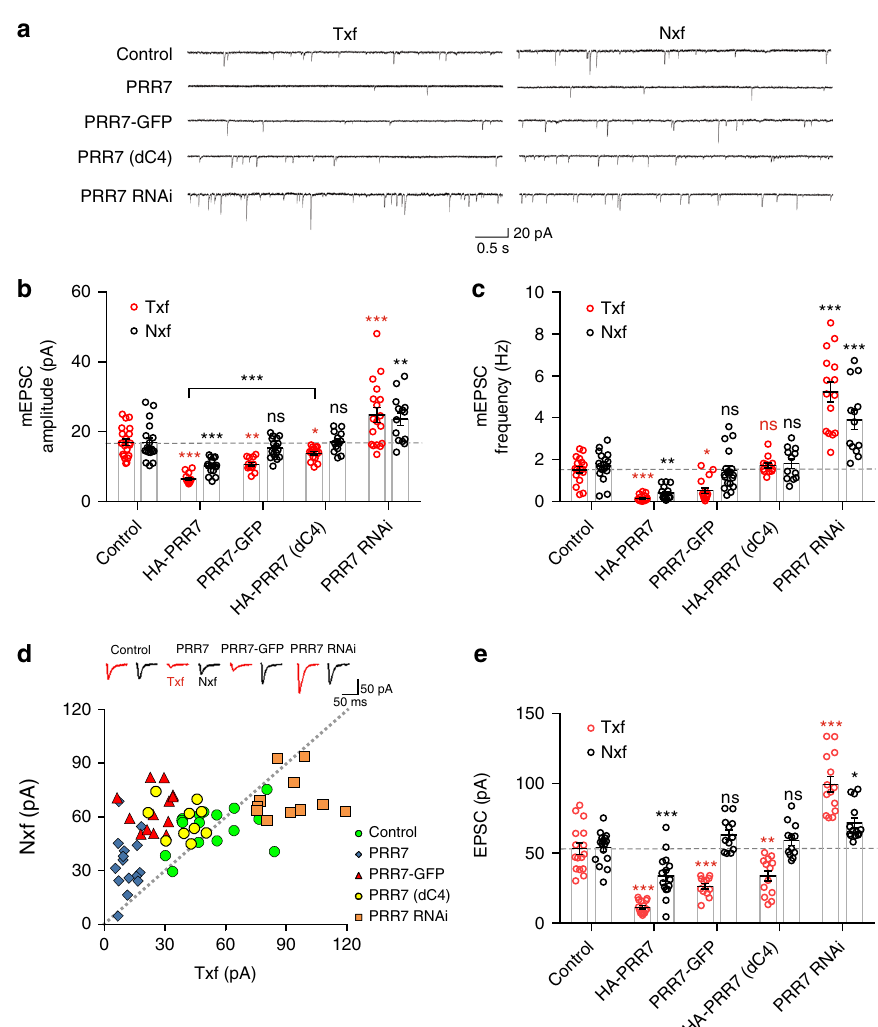
Fig. 3 PRR7 regulates excitatory synaptic transmission of local hippocampal neurons. a – c Effect of various PRR7 constructs on AMPAR-mediated mEPSCs in dissociated hippocampal neuron culture. Representative traces ( a ) and quanti fi cation of mEPSC amplitude ( b ) and frequency ( c ). n = 14 – 21. d , e Effect of various PRR7 constructs on evoked EPSCs measured by simultaneous whole-cell recordings from Txf and Nxf neurons of CA1 pyramidal cells in organotypic hippocampal slice culture. n = 12 – 16. Data are represented as scattered plots showing individual data points and mean ± SEM. Two-way ANOVA, post hoc Tukey ’ s test: F 4,150 = 46.2 ( b ), F 4,143 = 85.45 ( c ), and F 4,129 = 81.24 ( e ). *** P < 0.0001, ** P < 0.001, * P < 0.01, and ns not signi fi